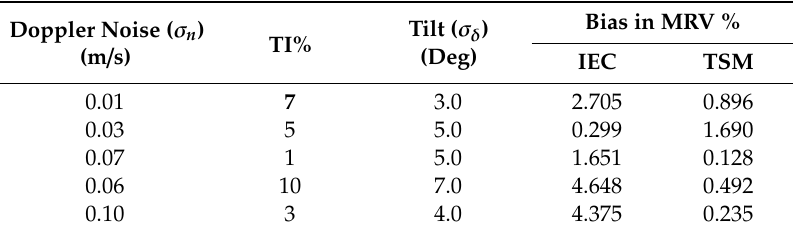
Table 6. Examples for acceptable combinations of uncertainty factors of MRV with 5% threshold in MRV